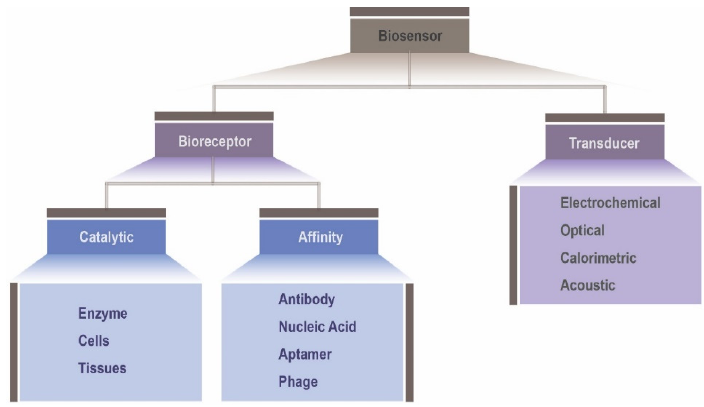
Figure 1. Biosensor classifications system.